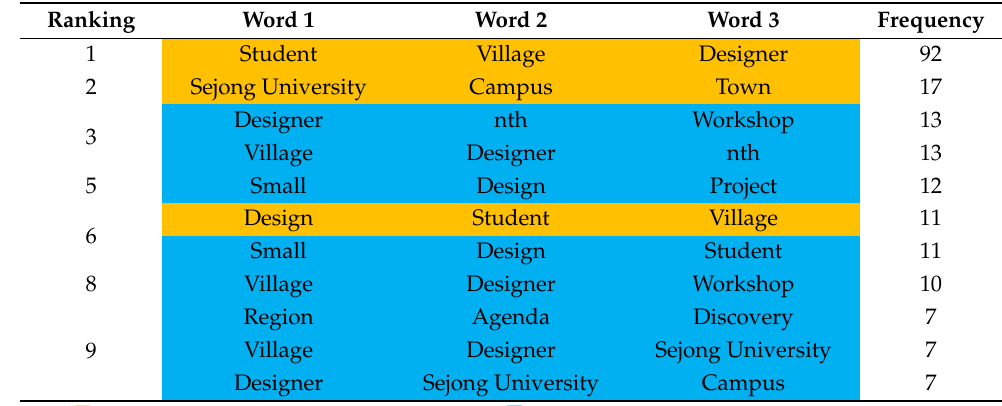
Table 6. Phrases of 3-g frequently used by students.